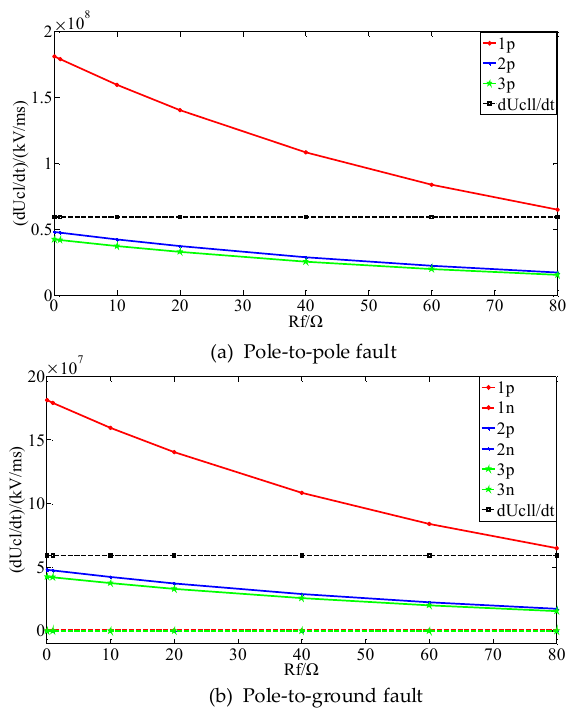
Figure 7. Voltage change rates of the CLIs during DC faults with different fault resistances.